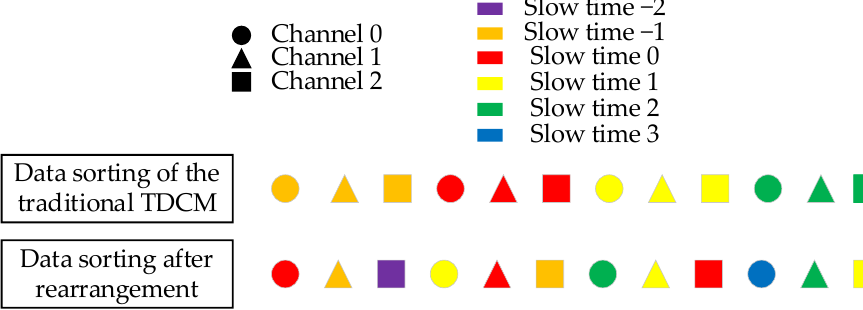
Figure 4. Distributed SAR data sorting after rearrangement.